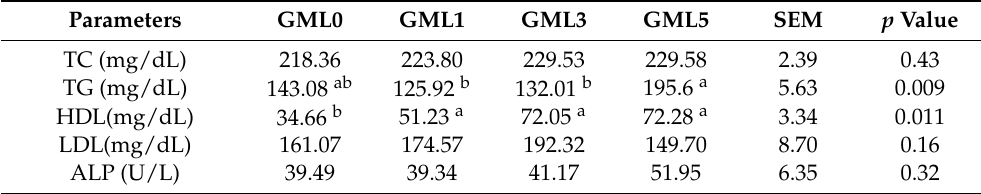
Table 5. The effect of glycerol monolaurate supplementation on the lipid profile and the level of alkaline phosphatase (ALP) of broiler chickens.